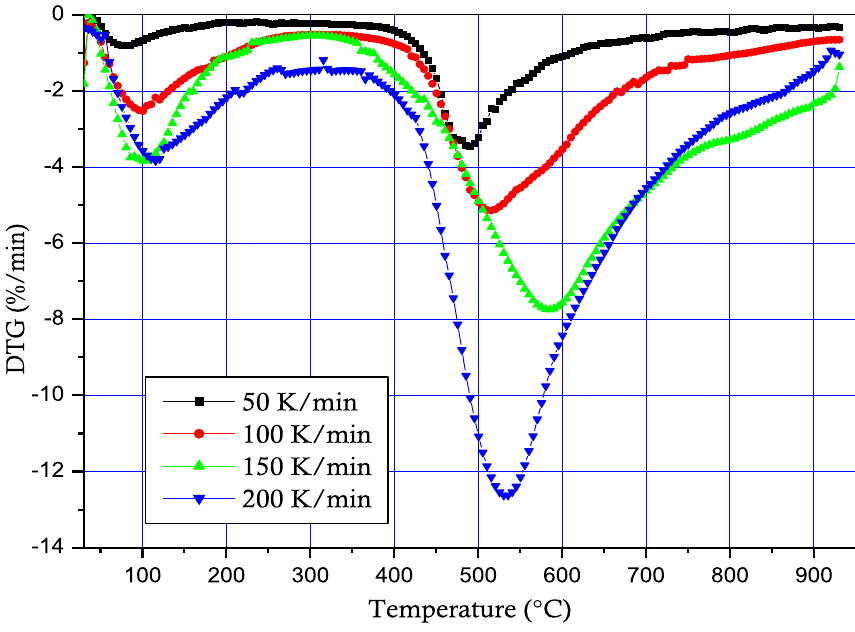
Fig. 10 DTG curves at different heating rate on low rank coal pyrolysis process Table 6 Value of Coefficient of determination (R-Square)